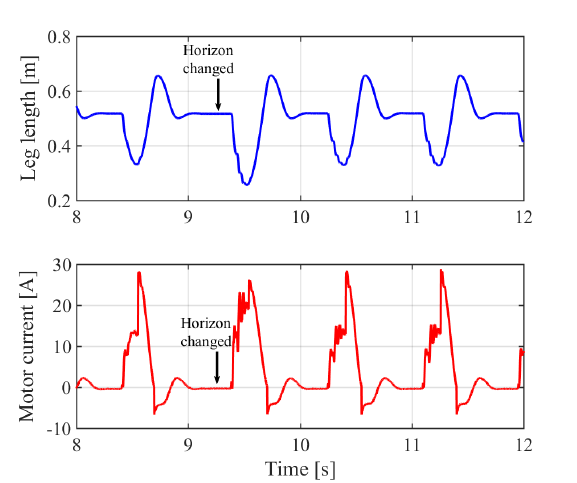
Figure 11. Data recorded during constant height hopping: (top) leg length; and (bottom) motor current of Joint